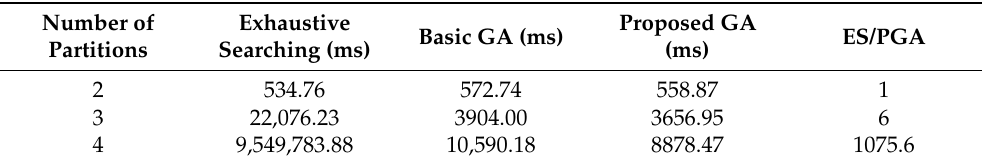
Table 10. Comparison of the average computation time for generating a deployment plan of a given